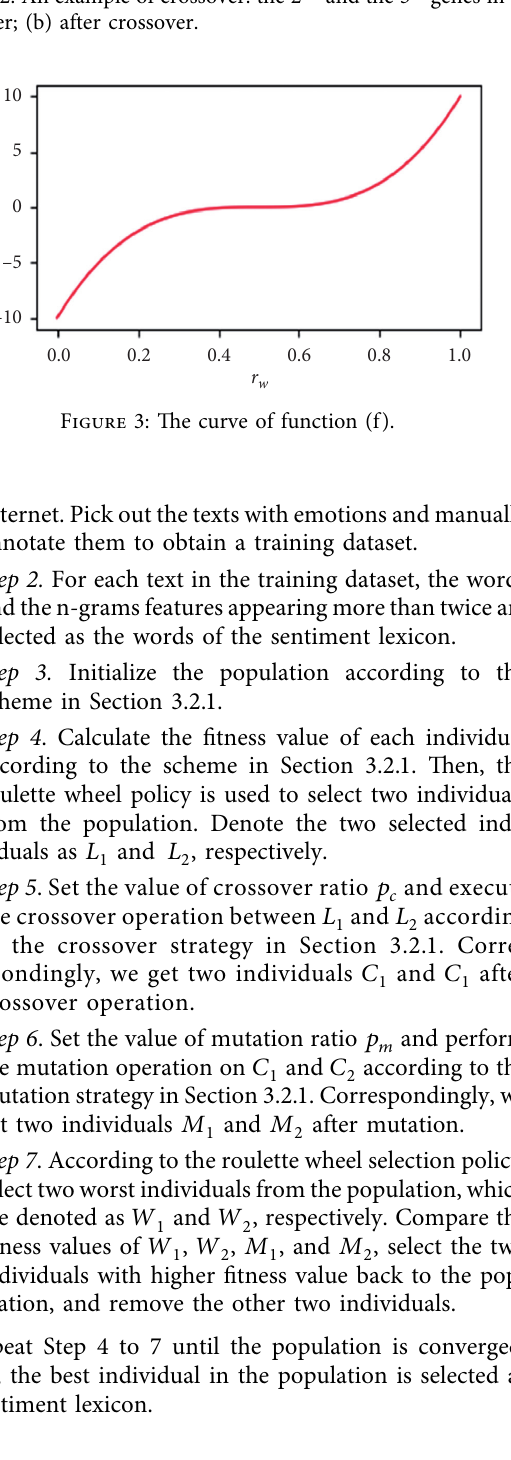
1 are exchanged with the genes of (L) 2 in the same position: (a) before